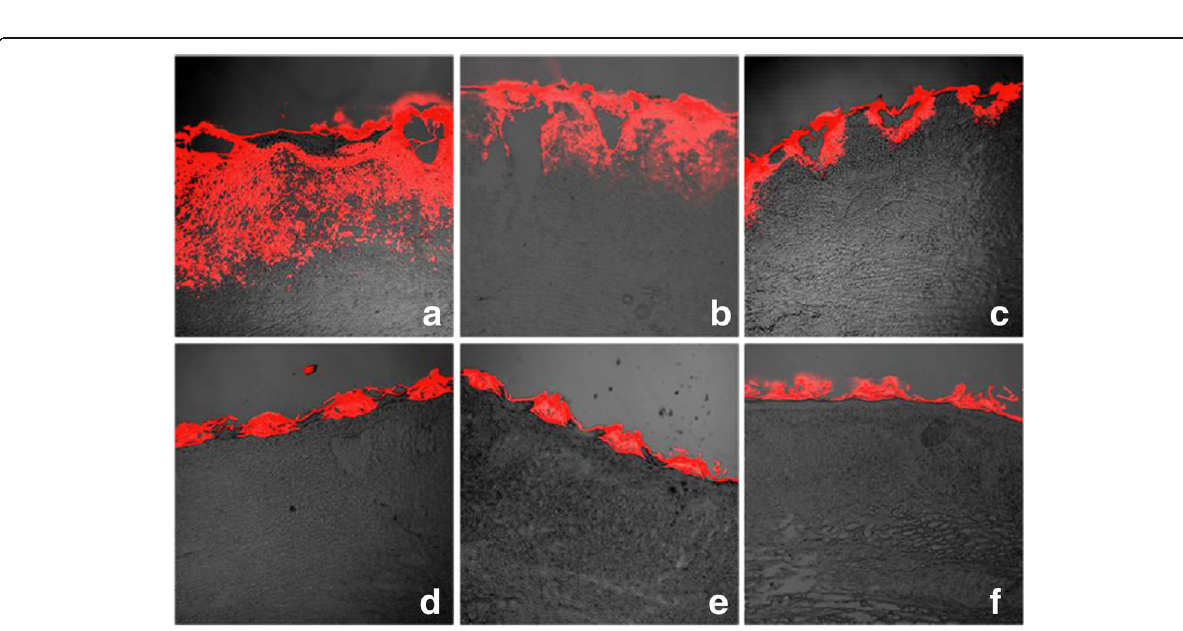
Fig. 4 CO 2 fractional laser promotes micro-channel opening rates in vivo. The red fluorescence is labeled ethosomes permeate rabbit ear hypertrophic scar tissues 0 h ( a ), 6 h ( b ), 12 h ( c ), 24 h ( d ), 3 days ( e ), and 7 days ( f ) after CO 2 fractional laser treatment in